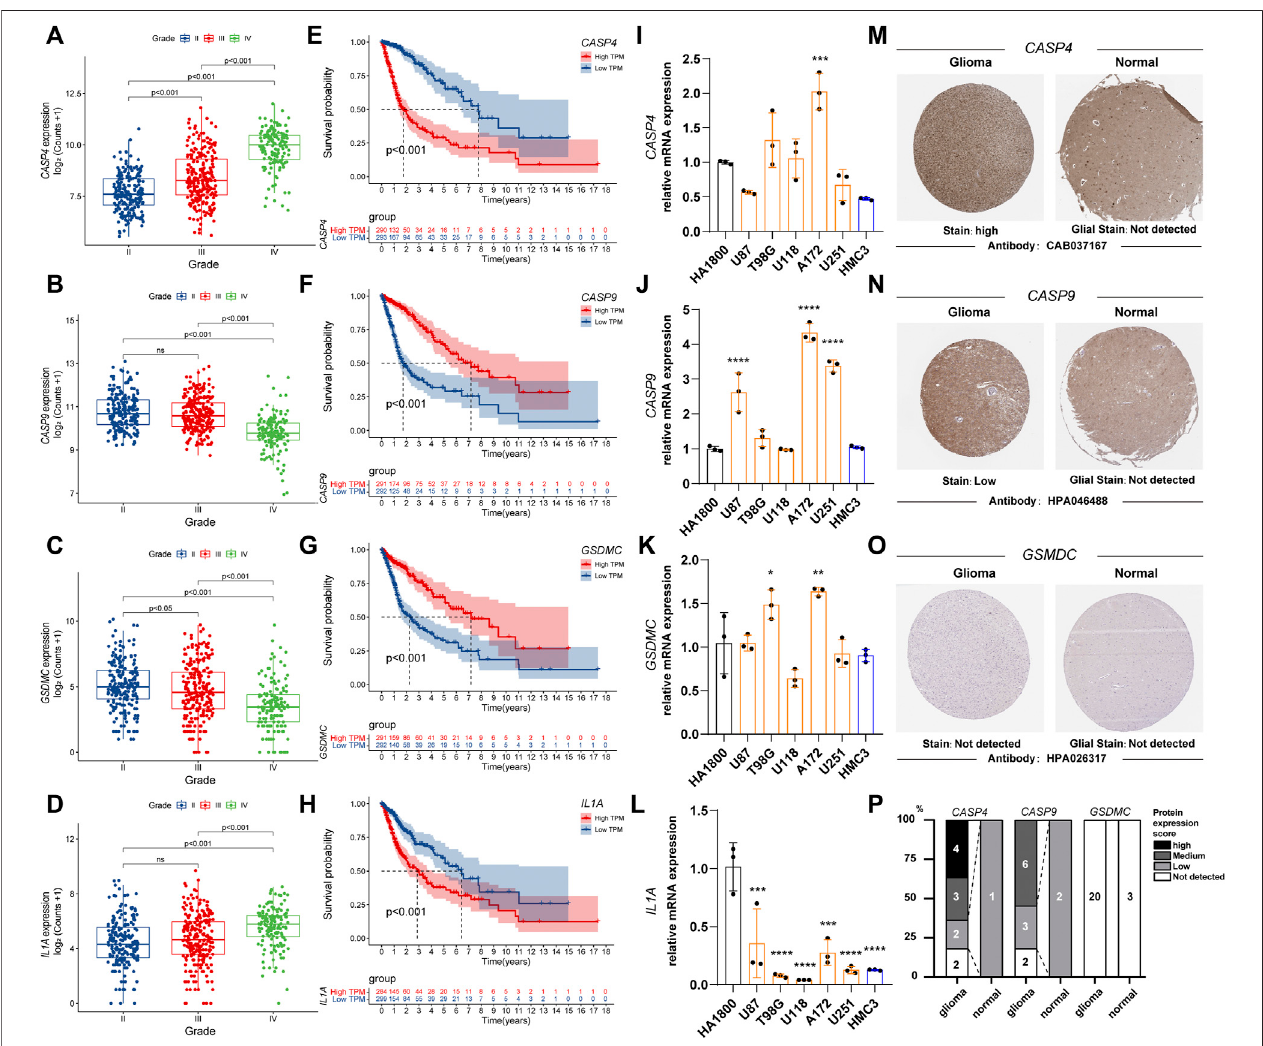
FIGURE 3 | The relationship between the expression status of the PRGs signature and the tumor grade and prognosis. (A – D) Box plot of PRGs signature expression with tumor grade. (E – H) Overall survival of different PRGs signature expression in glioma. (I – L) Relative mRNA expression of PRGs signature in different cell lines by qPCR. (* p < 0.05, ** p < 0.01, *** p < 0.001. **** p < 0.0001, Not labeled: no statistical signi fi cance compared to HA 1800). (M – O) Representative protein expression images of PRGs signature by the Human Protein Atlas (HPA). (P) Statistical column stacking diagram of PRGs signature protein expression in HPA. PRGs, Pyroptosis Related genes. qPCR, quantitative Polymerase Chain Reaction. PRGs, Pyroptosis Related genes.